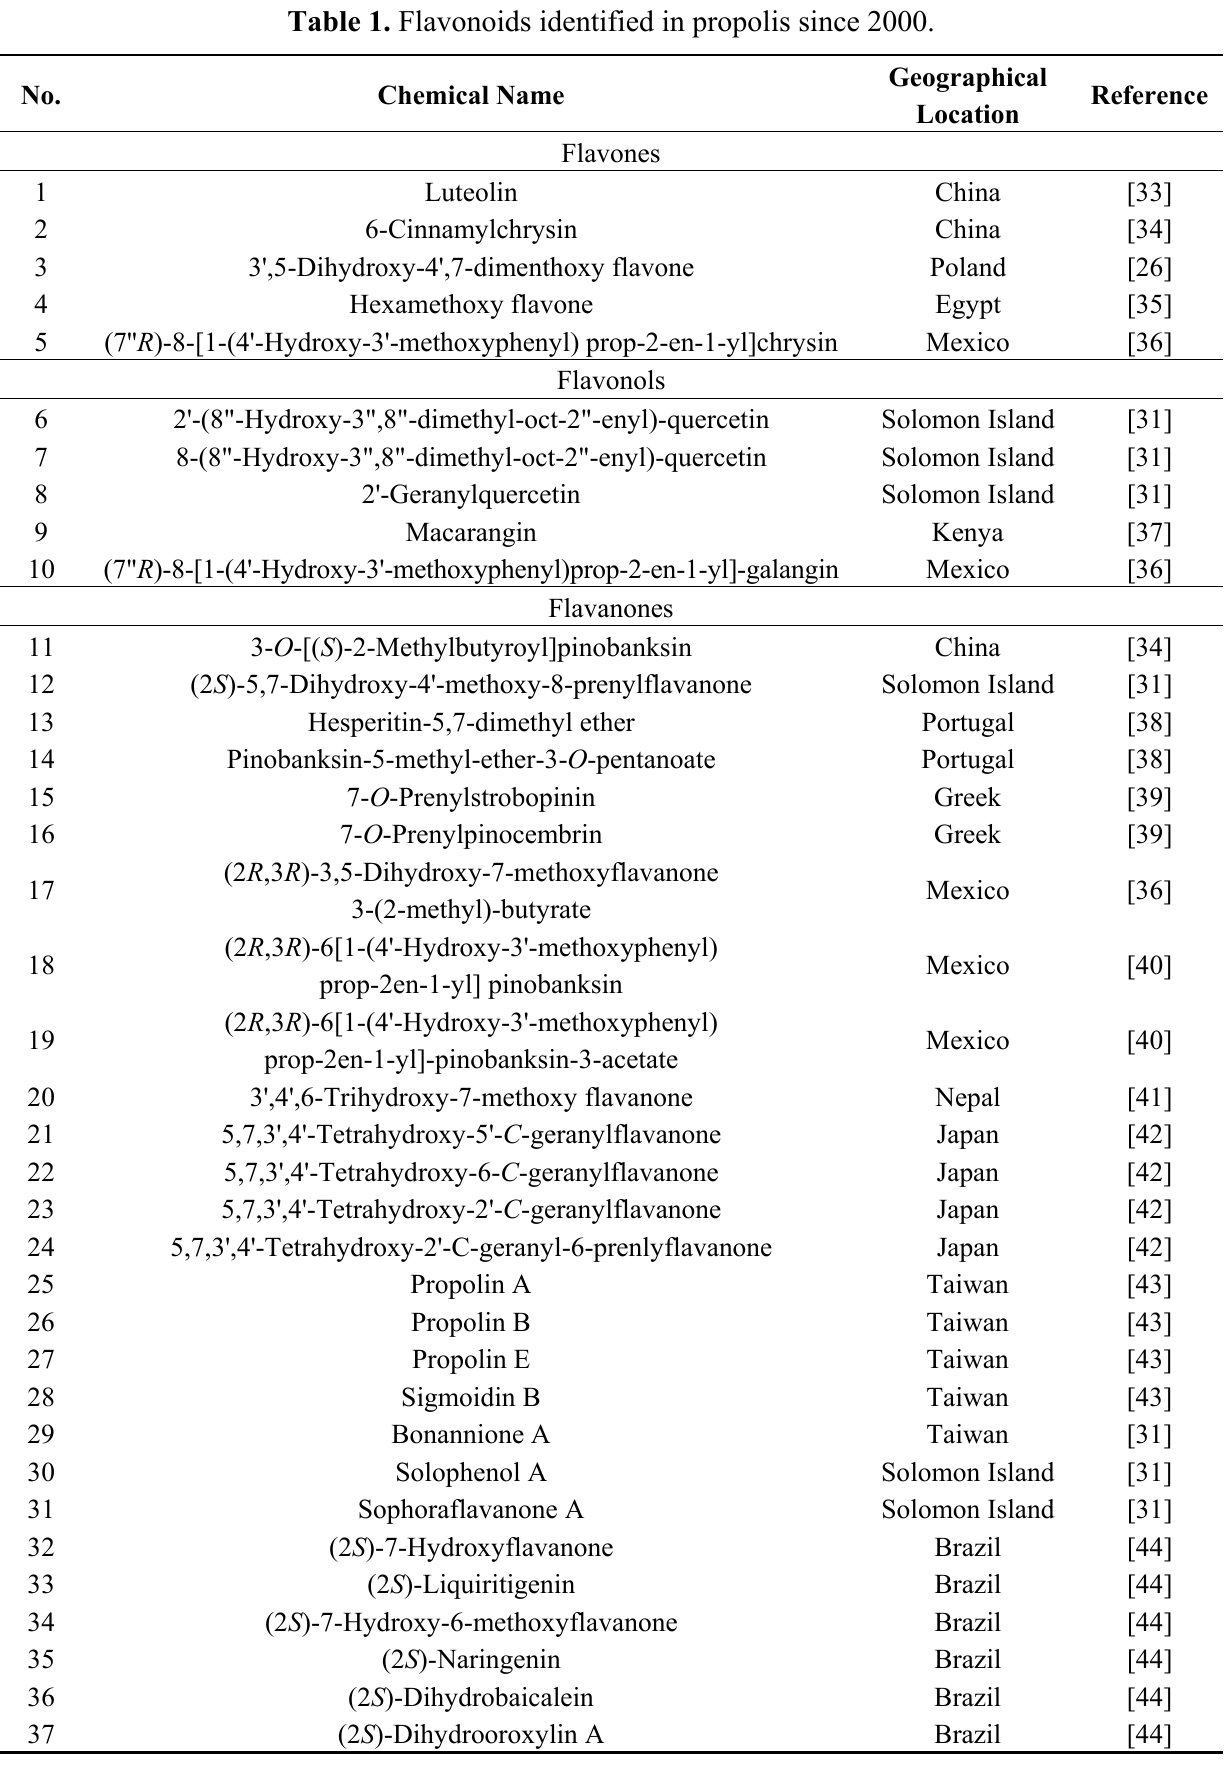
Table 1. Flavonoids identified in propolis since